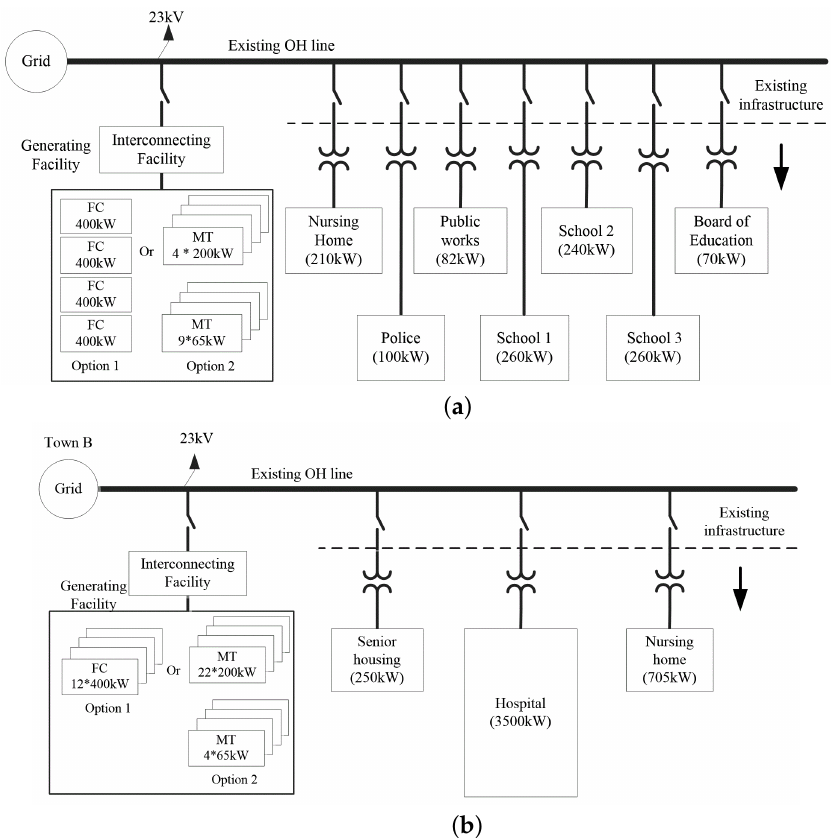
Figure 4. Microgrid configuration for critical load of a selected town: ( a ) Town A; and ( b ) Town B.